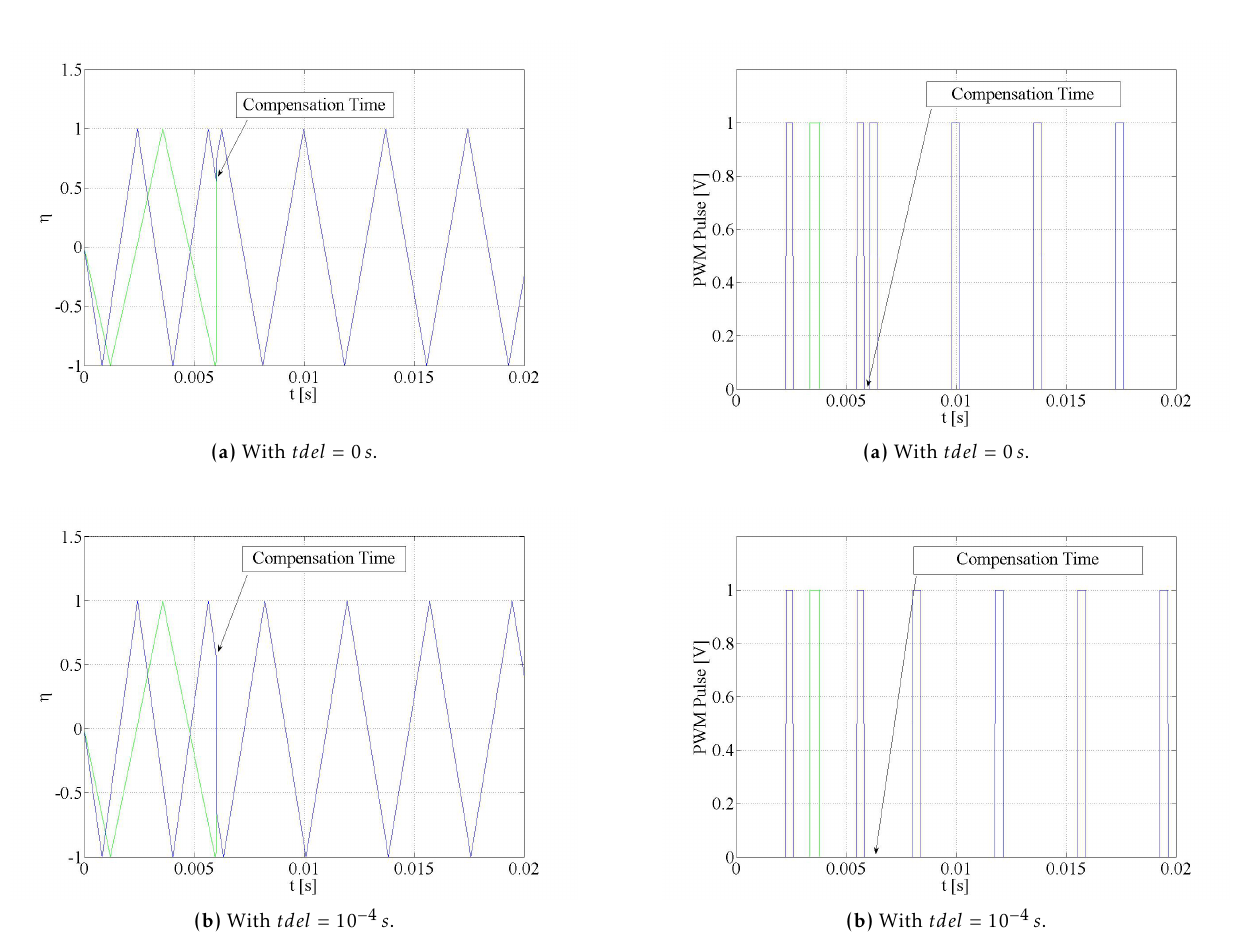
Figure 11. The PWM modulation waveform convergence behaviors of the two nodes.